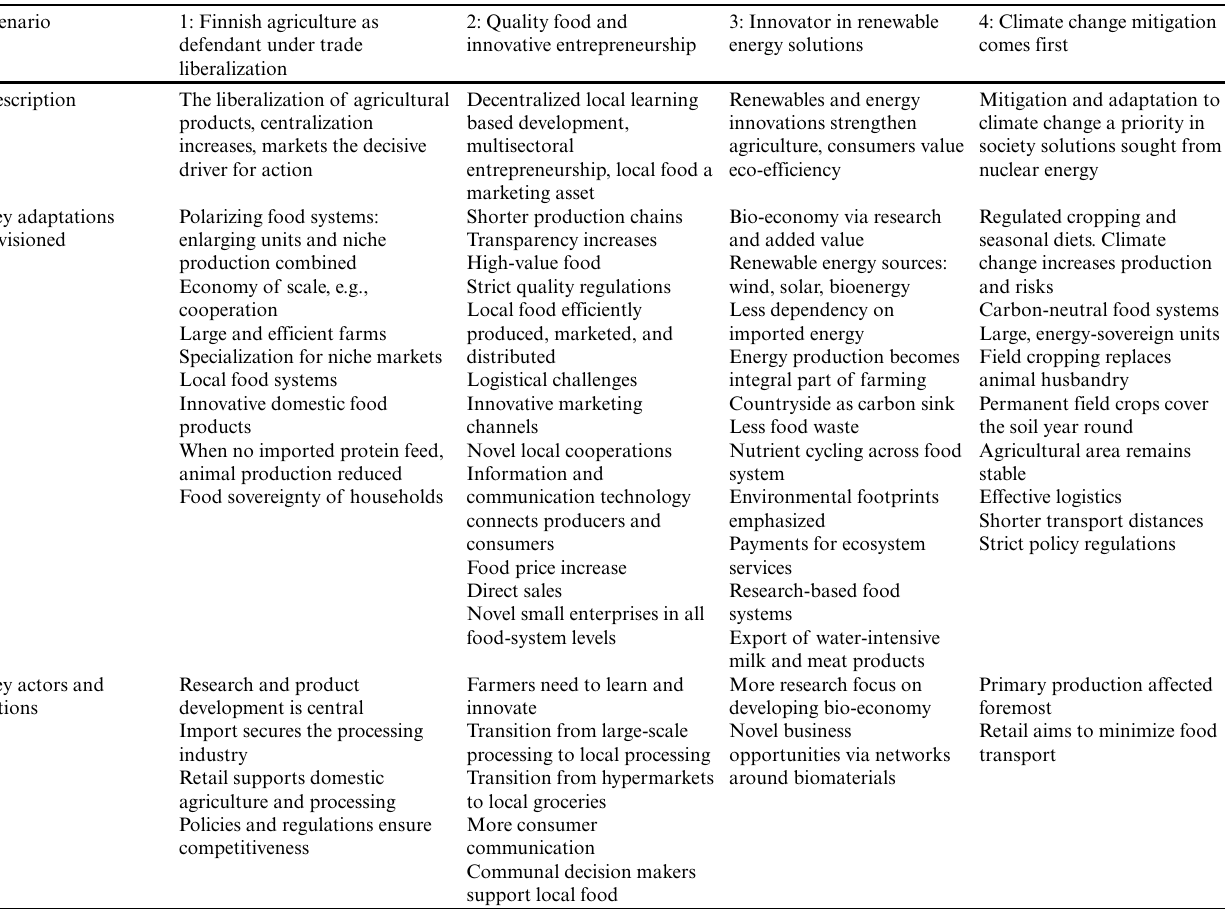
Table 2 . Delphi panel views on potential adaptations of food systems to various future scenarios in Finland (Niemi and Rikkonen 2010), and the actors and actions having a key role in each